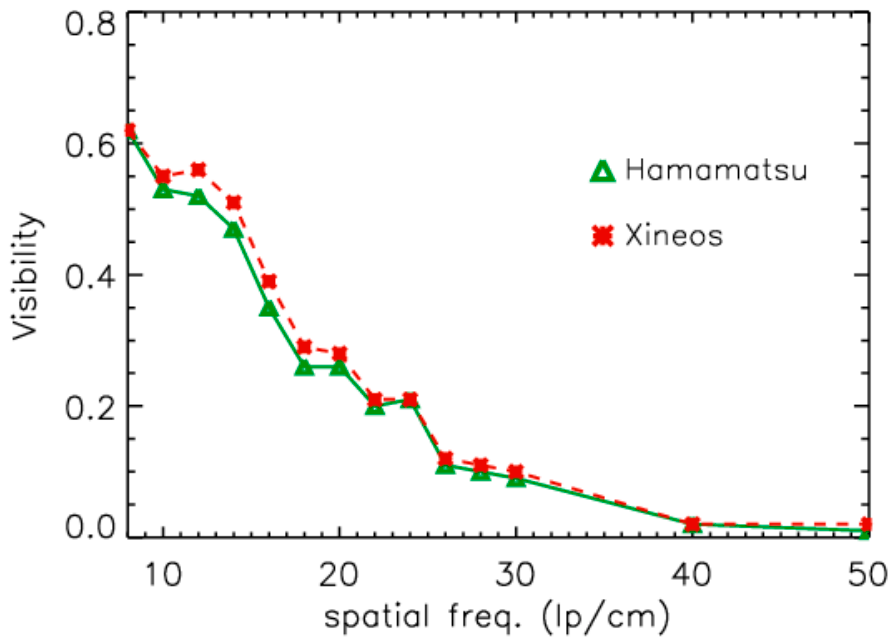
Figure 6. Comparison of the line pattern visibility for PCT images obtained using data from the Hamamatsu and the Xineos detectors as a function of the spatial frequency of the resolution test phantom (expressed as line pairs/cm).